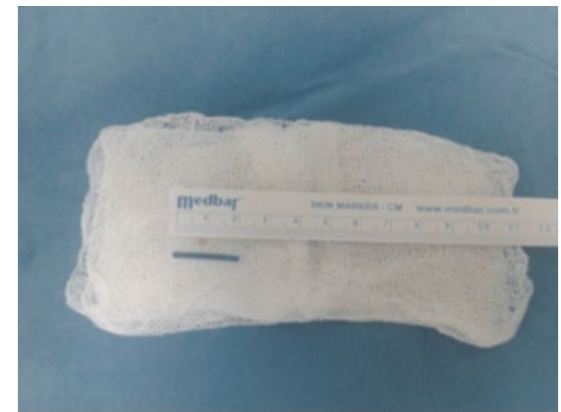
Fig. 3 A piece of the stent removed from the left pulmonary parenchyma via a video thorascopic